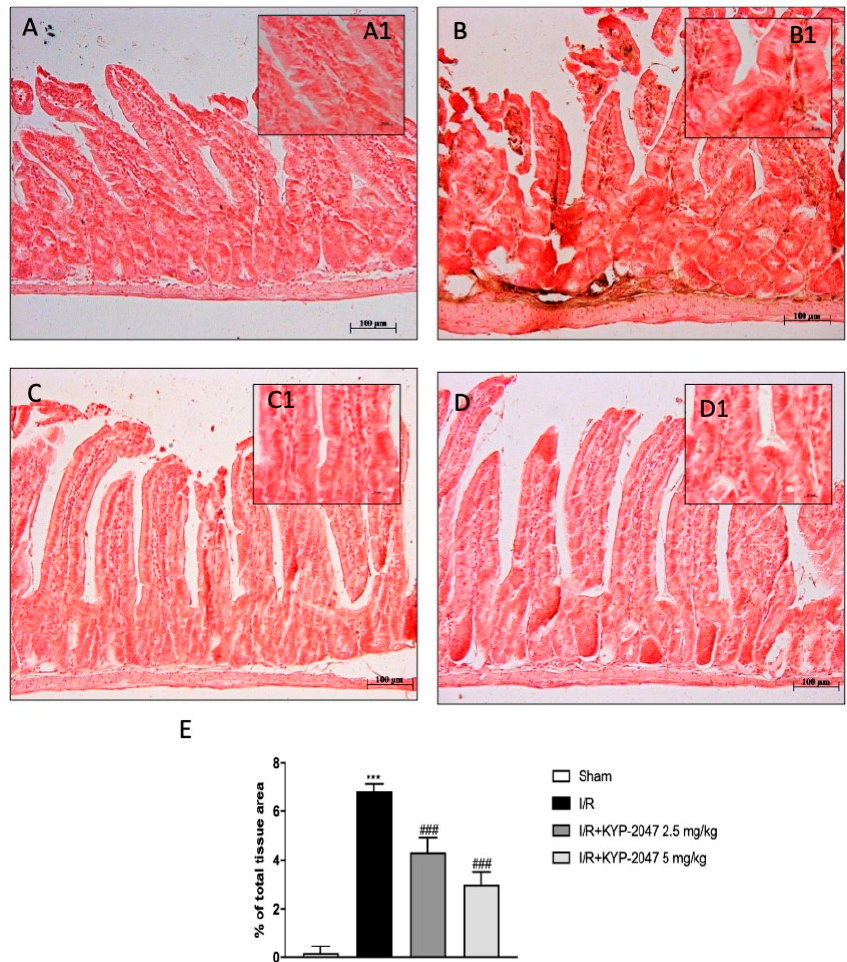
Figure 5. Effect of KYP-2047 treatments on CD34 expression in the tunica mucosa of the intestine. ( A ) No CD34 immunoreactivity was shown in control intestines. ( A1 ) 20 × magnification panel A. ( B ) CD34 immunoreactivity was increased after IRI. ( B1 ) 20 × magnification panel A. ( C , D ) CD34 immunoreactivity was decreased in the KYP-2047 groups (2.5 mg/kg and 5 mg/kg). ( C1,D1 ) 20 × magnification panel C and D, respectively. ( E ) Immunohistochemical analysis of CD34. Data are representative of at least three independent experiments. *** p < 0.001 vs. sham; ### p < 0.001 vs. IRI.